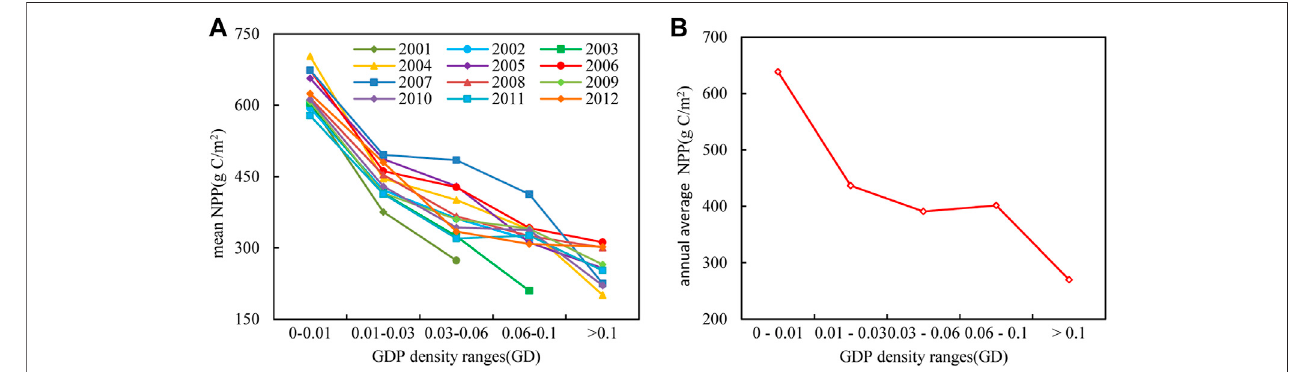
FIGURE 11 | (A) NPP and GDP density from 2001 to 2012 and (B) annual average NPP and its regression slope with GDP